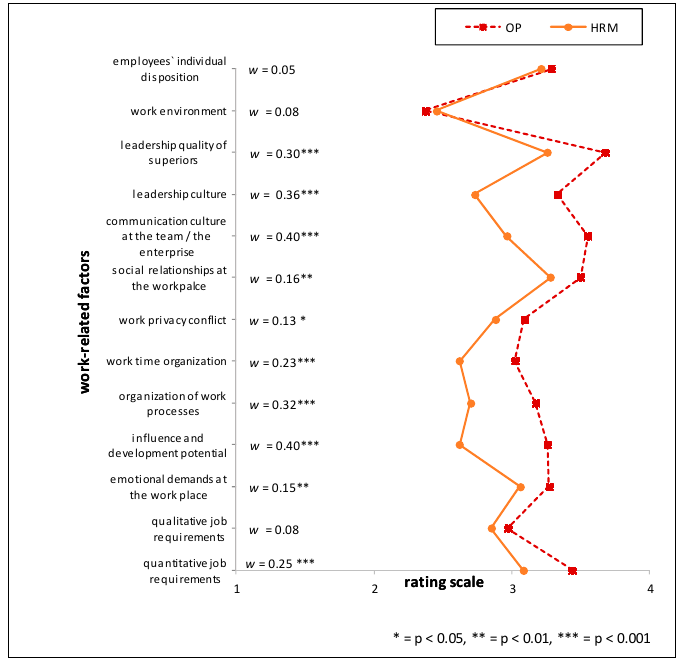
Figure 1. Polarity profile across work-related factors potentially important for (stress-associated) mental disorders in employees comparing the mean value ratings from “not at all important” (1) to “very important” (4) of Human Resource Managers (HRM) and Occupational Physicians (OP), w = effect size of differences.